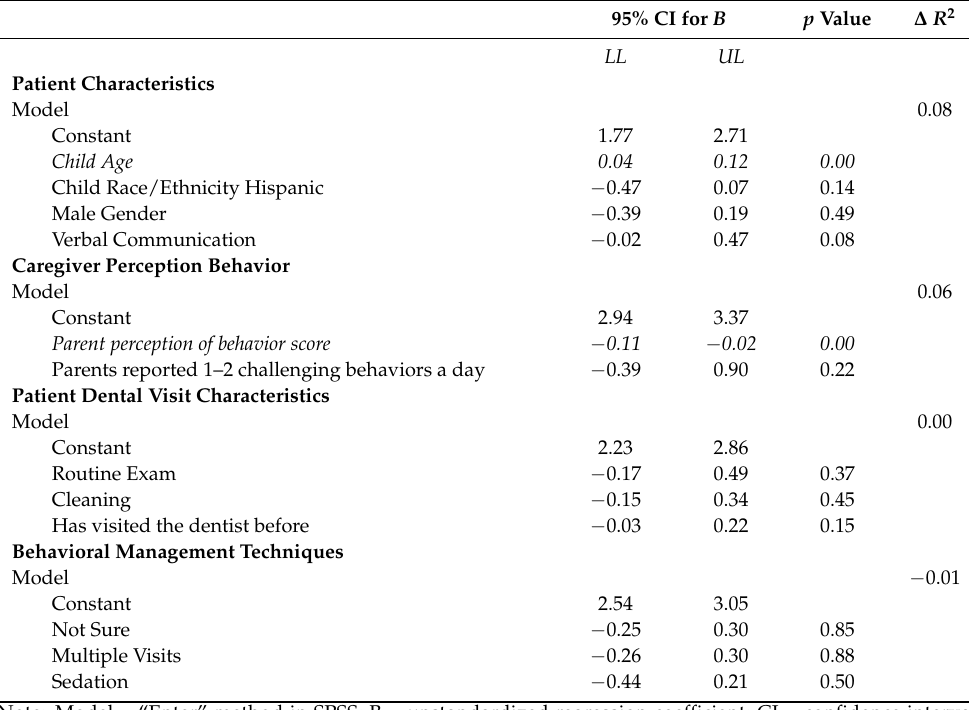
Table 6. Regression analysis to predict productivity level achieved during the first dental appointment, as measured by Frankl (N =